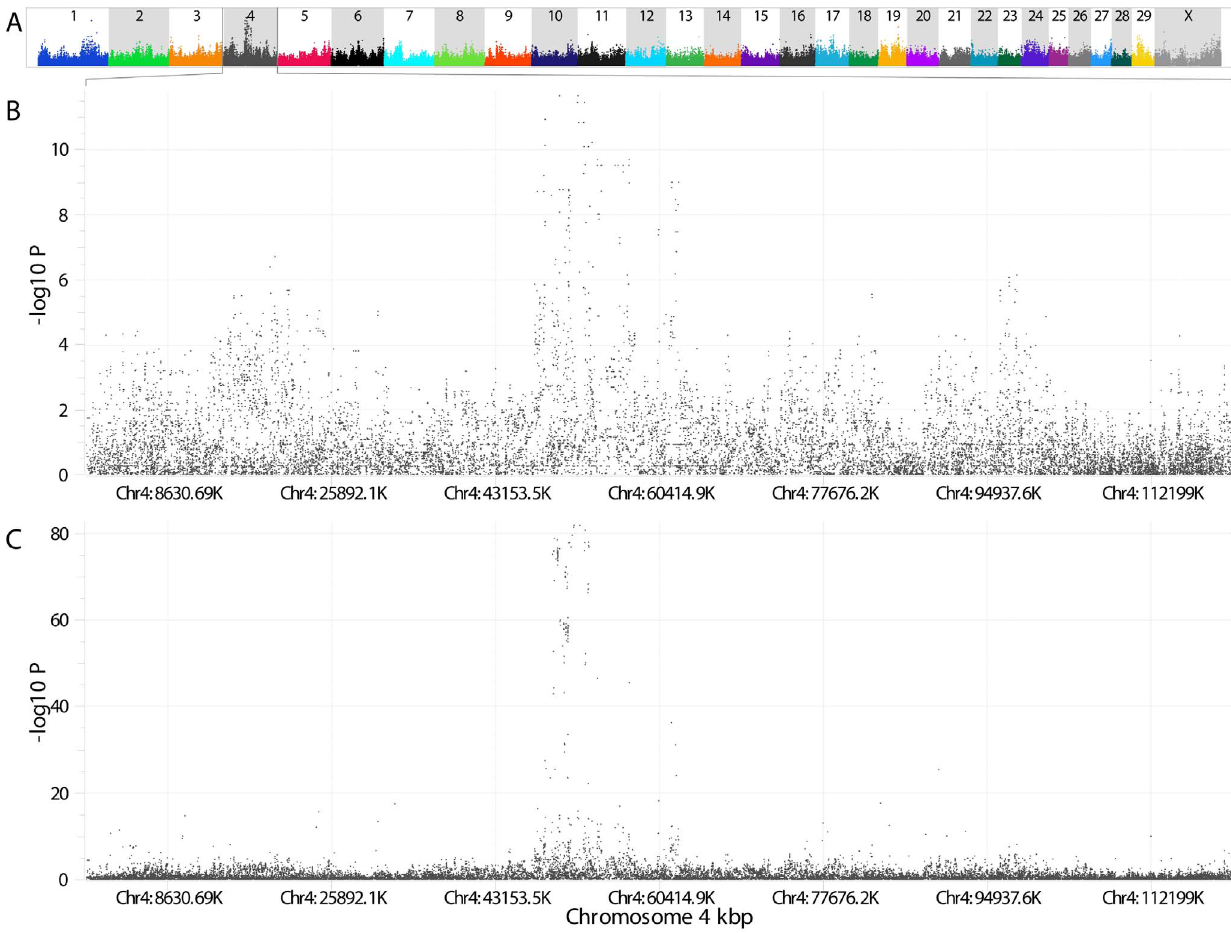
Figure 1. Weaver Syndrome GWAS. GWAS results using reported Weaver phenotypes for 72 individuals with HDSNP genotypes for A ) all BTAs B ) BTA 4. C ) GWAS results for BTA 4 using reported Weaver phenotypes for 829 individuals with target, 50K, and/or HD genotypes. UMD3.1 coordinates used.